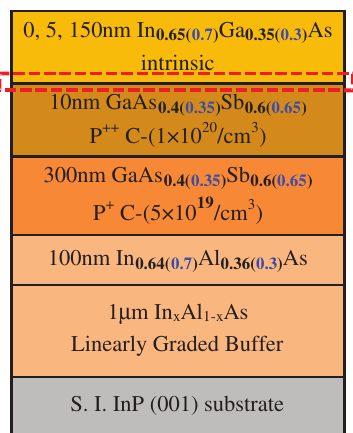
Figure 30 (A) Schematic diagram of GaAsSb/InGaAs heterostruc- tures with different InGaAs thickness for band offset measure- ments: 5 nm InGaAs/310 nm GaAsSb was used for the measure- ment of binding energy at the heterointerface, whereas 150 nm InGaAs/310 nm GaAsSb and 310 nm GaAsSb without the top InGaAs layer were used to measure the binding energy of bulk InGaAs and GaAsSb, respectively. The dashed box denotes the source/channel interface. Reprinted from Ref. [13], with permission, from the